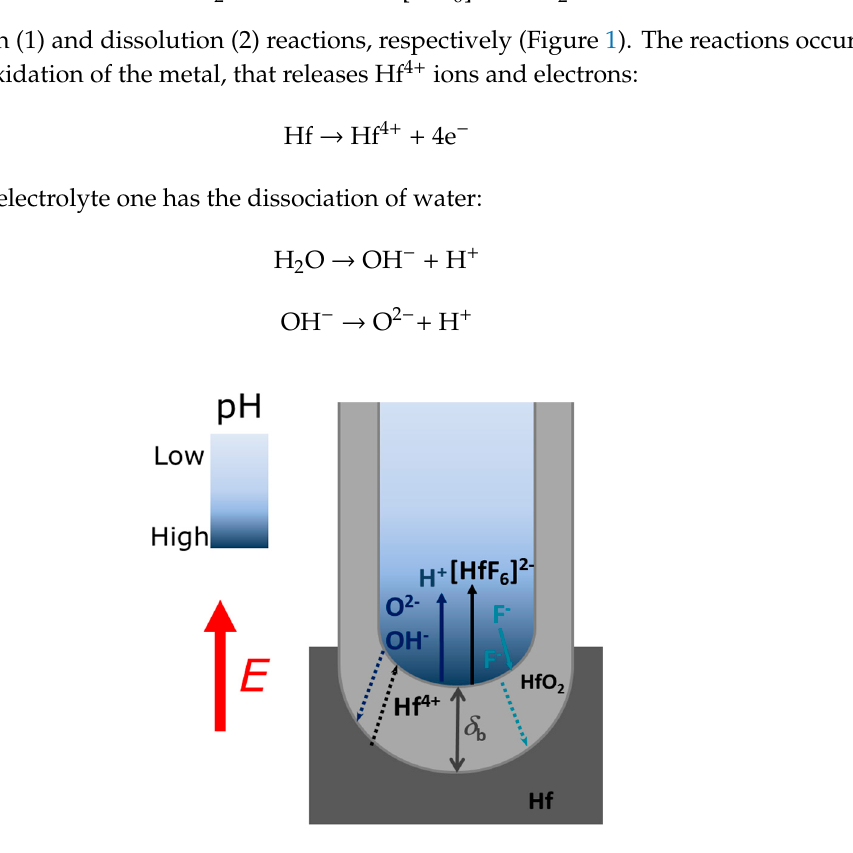
Figure 1. Scheme diagram illustrating the ions profiles inside the nanotubes (NTs) during the